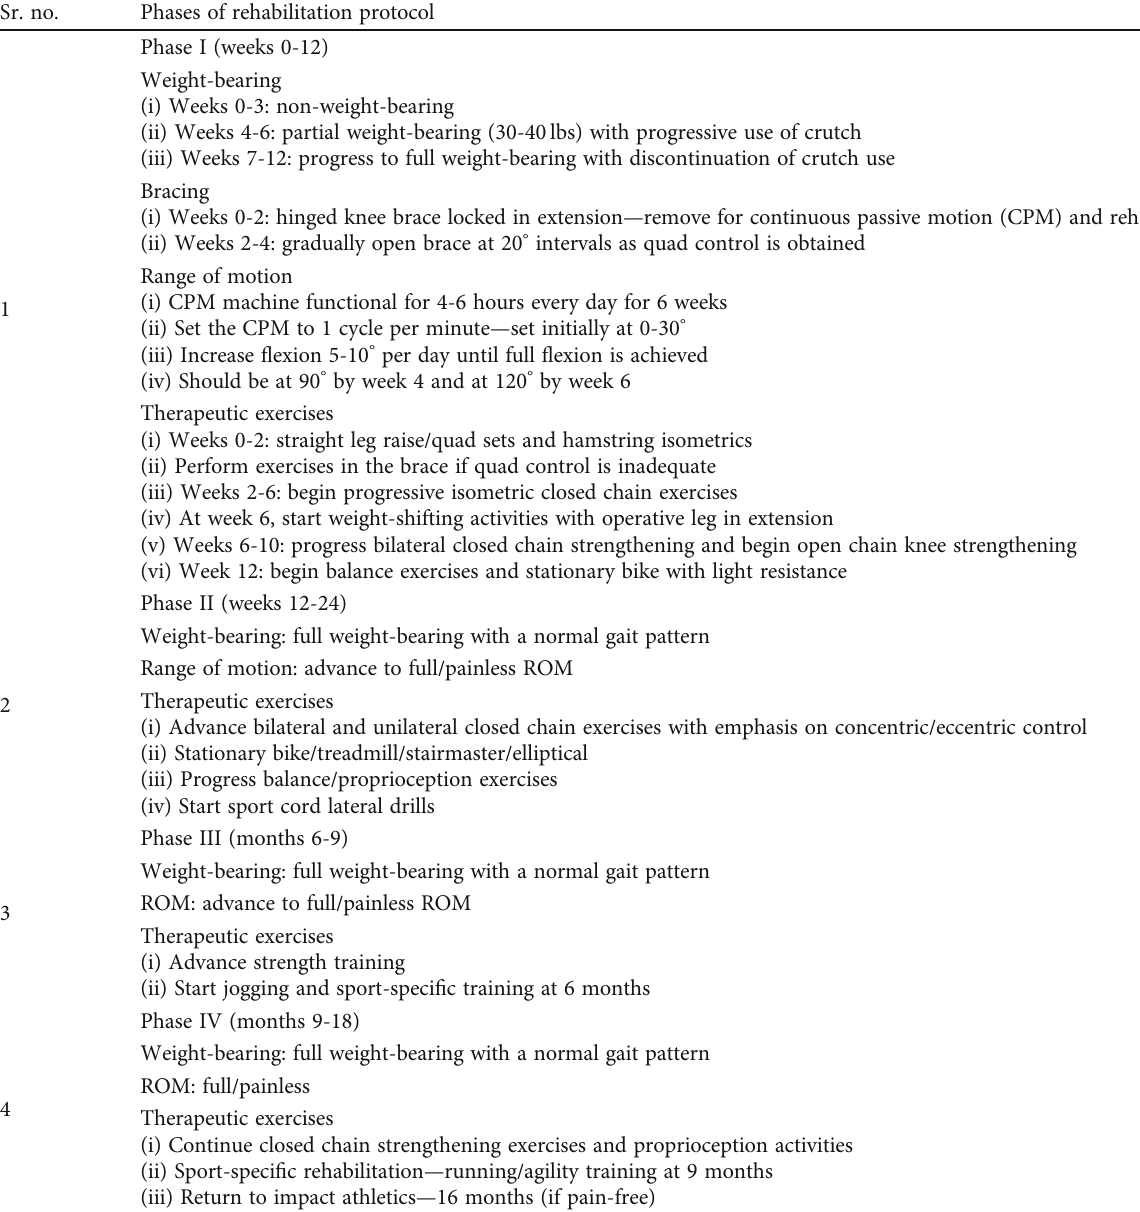
Table 1: Rehabilitation protocol of ACI in our center.